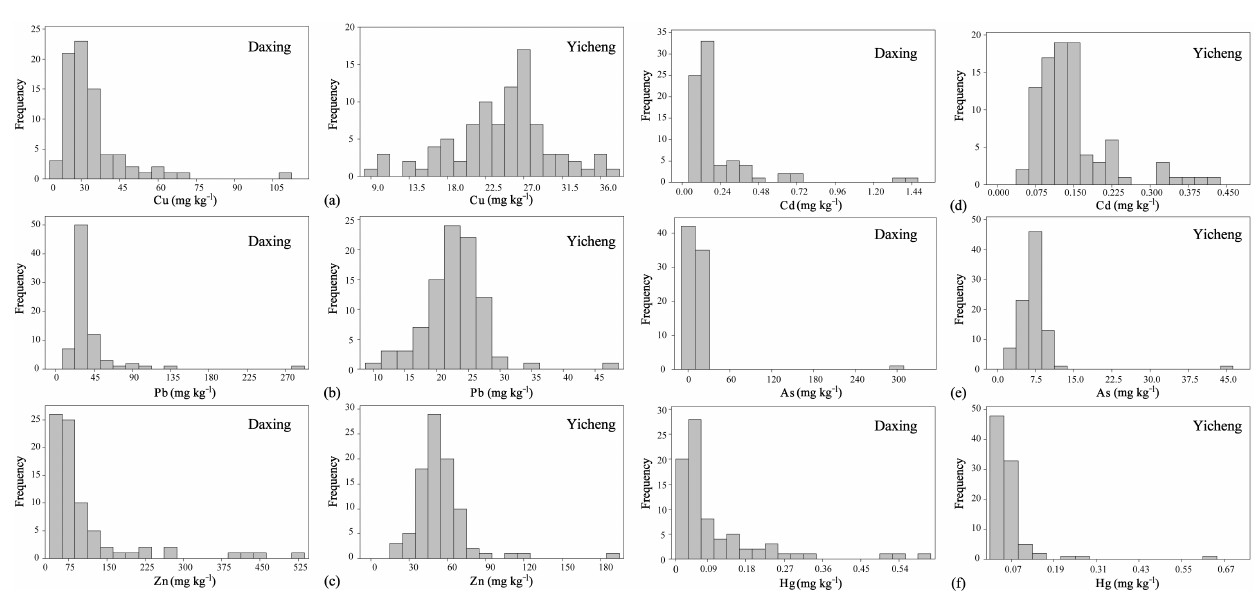
Figure 2. Histograms showing the distribution of Cu (a) , Pb (b) , Zn (c) , Cd (d) , As (e) , and Hg (f) concentrations within soils from the towns of Daxing and